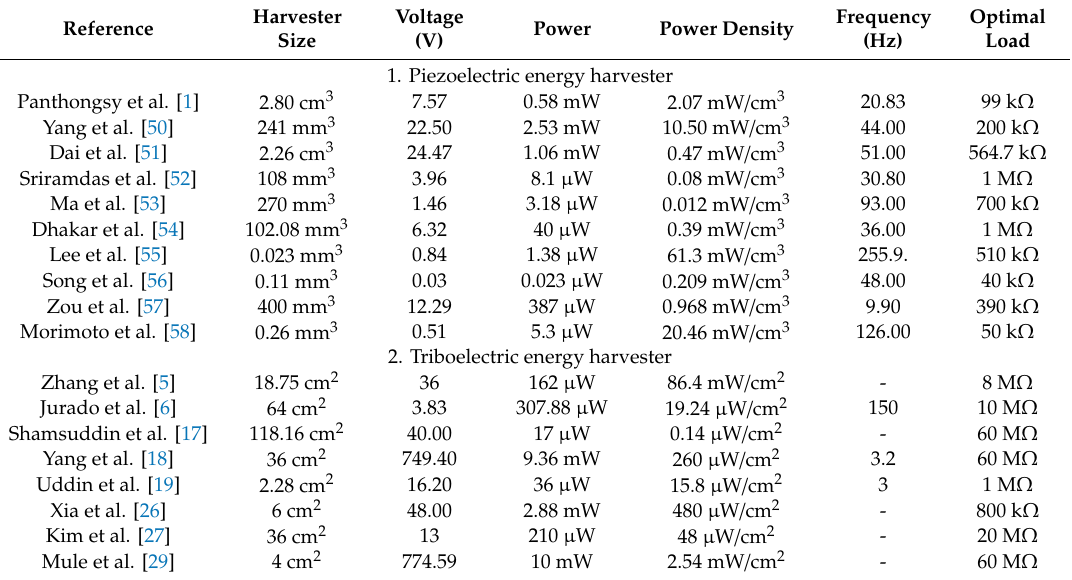
Table 4. Output performances of PEH and